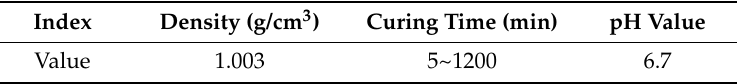
Table 1. Basic properties of polyurethane binder.